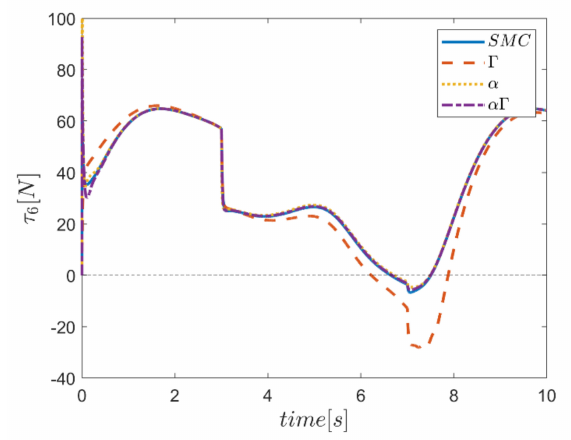
Figure 55. Comparison of the input force in the sixth actuator.